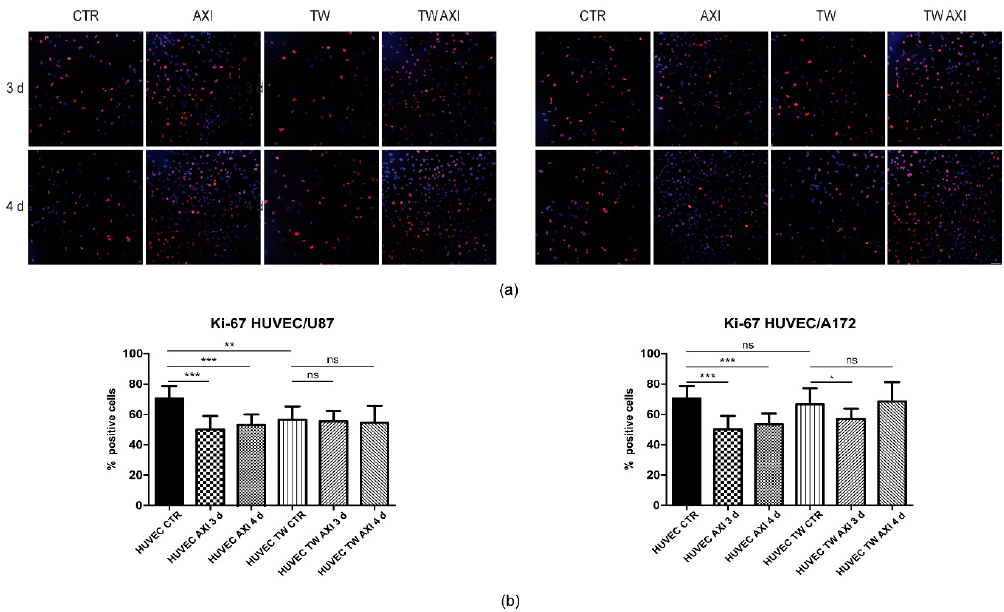
Figure 3. Proliferation rate of Axitinib-treated HUVECs was not affected by coculture with GBM cells. Ki-67 immunostaining was performed on control (sham-treated) HUVECs, either cultured alone or in transwell with U87MG ( a , b , left panel) or A172 ( a , b , right panel) GBM cells. Control cells, either single